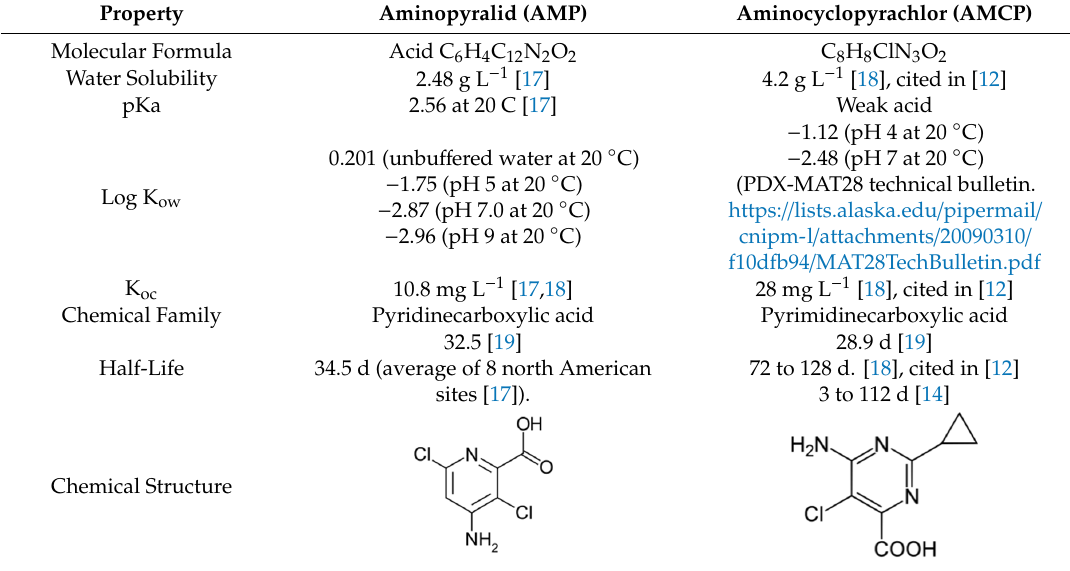
Table 1. Chemical properties and structures of the two bioactives tested, including aminopyralid (AMP) and aminocyclopyrachlor (AMCP).